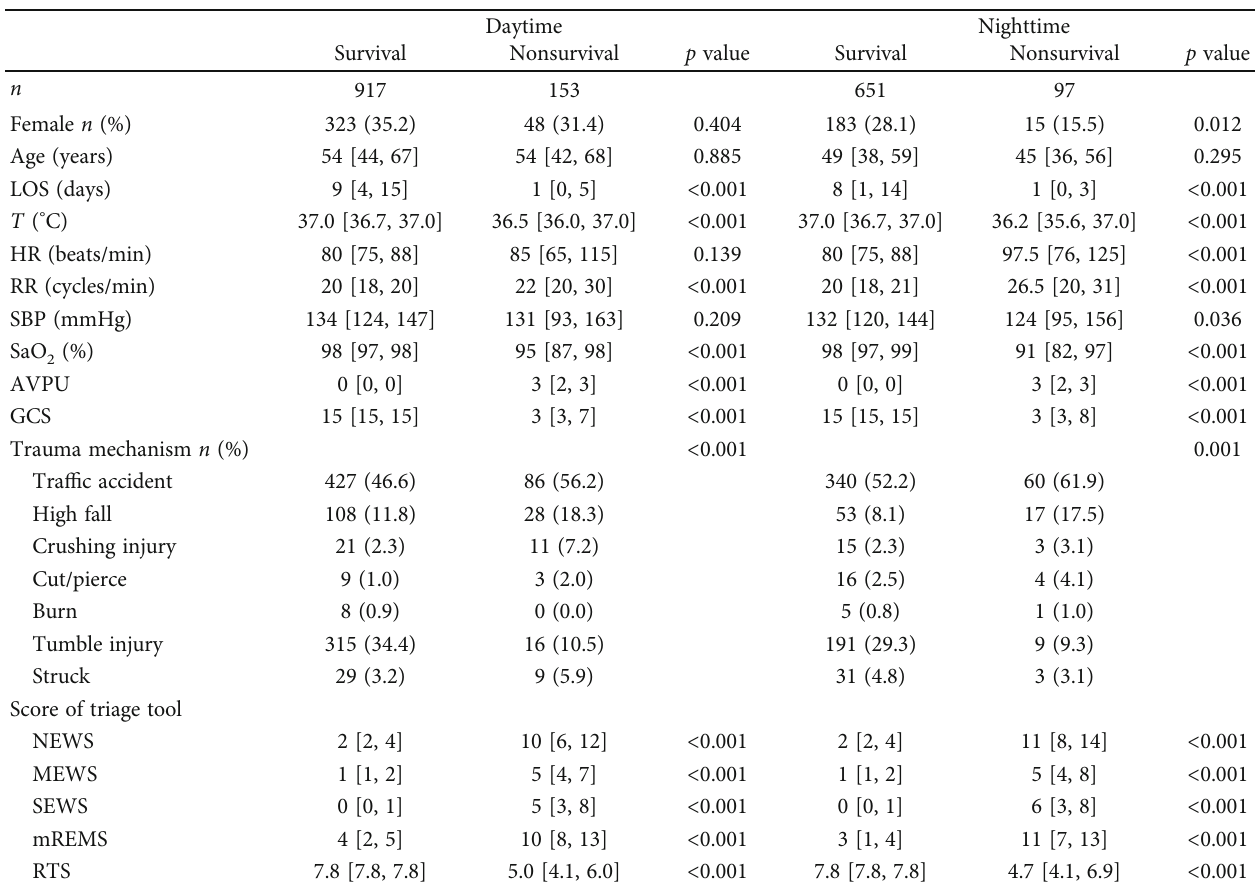
Table 2: Characteristics of the survival and nonsurvival groups among patients with multiple trauma admitted during the daytime and